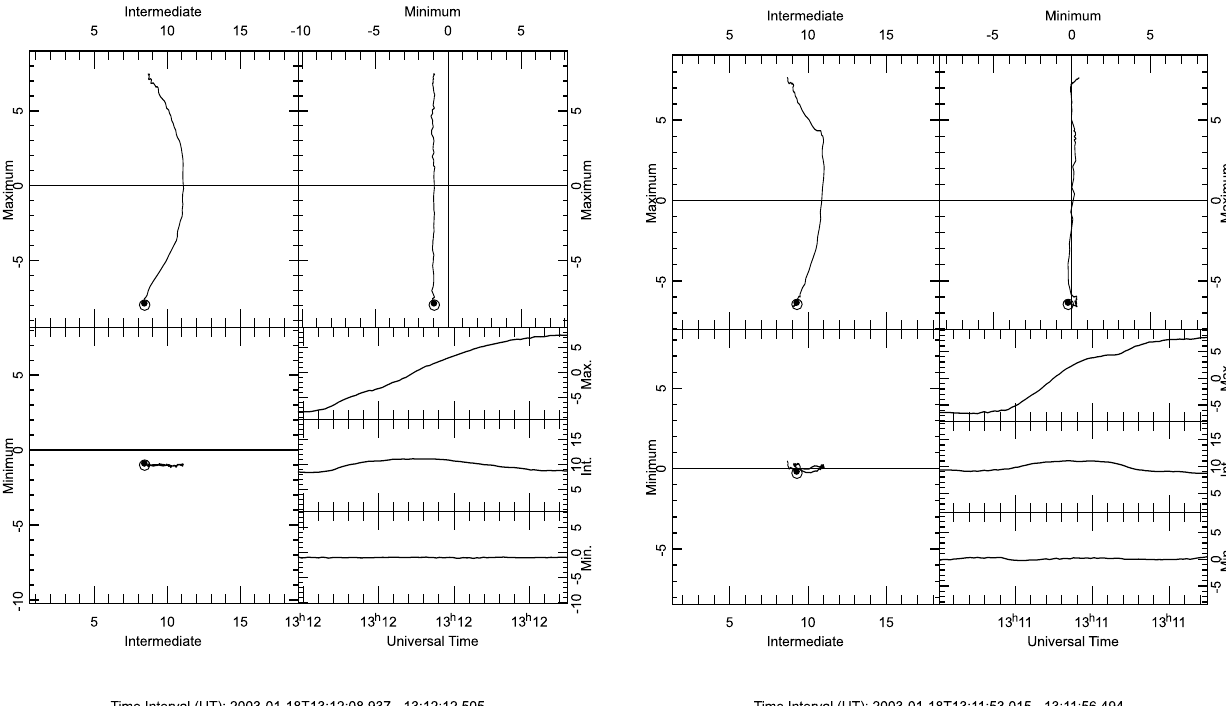
Fig. 3. Top panel: C1 hodogram projections for the data interval with the lowest dB n in Fig. 2 (time span used is 13:12:08.9 to 13:12:12.6; eigenvalue ratio is 318). Bottom panel: corresponding hodograms for spacecraft C3 (time span used is 13:11:53:1 to 13:11:56.4; eigenvalue ratio is 27). Panels on the lower right show time series of the three components. All units are